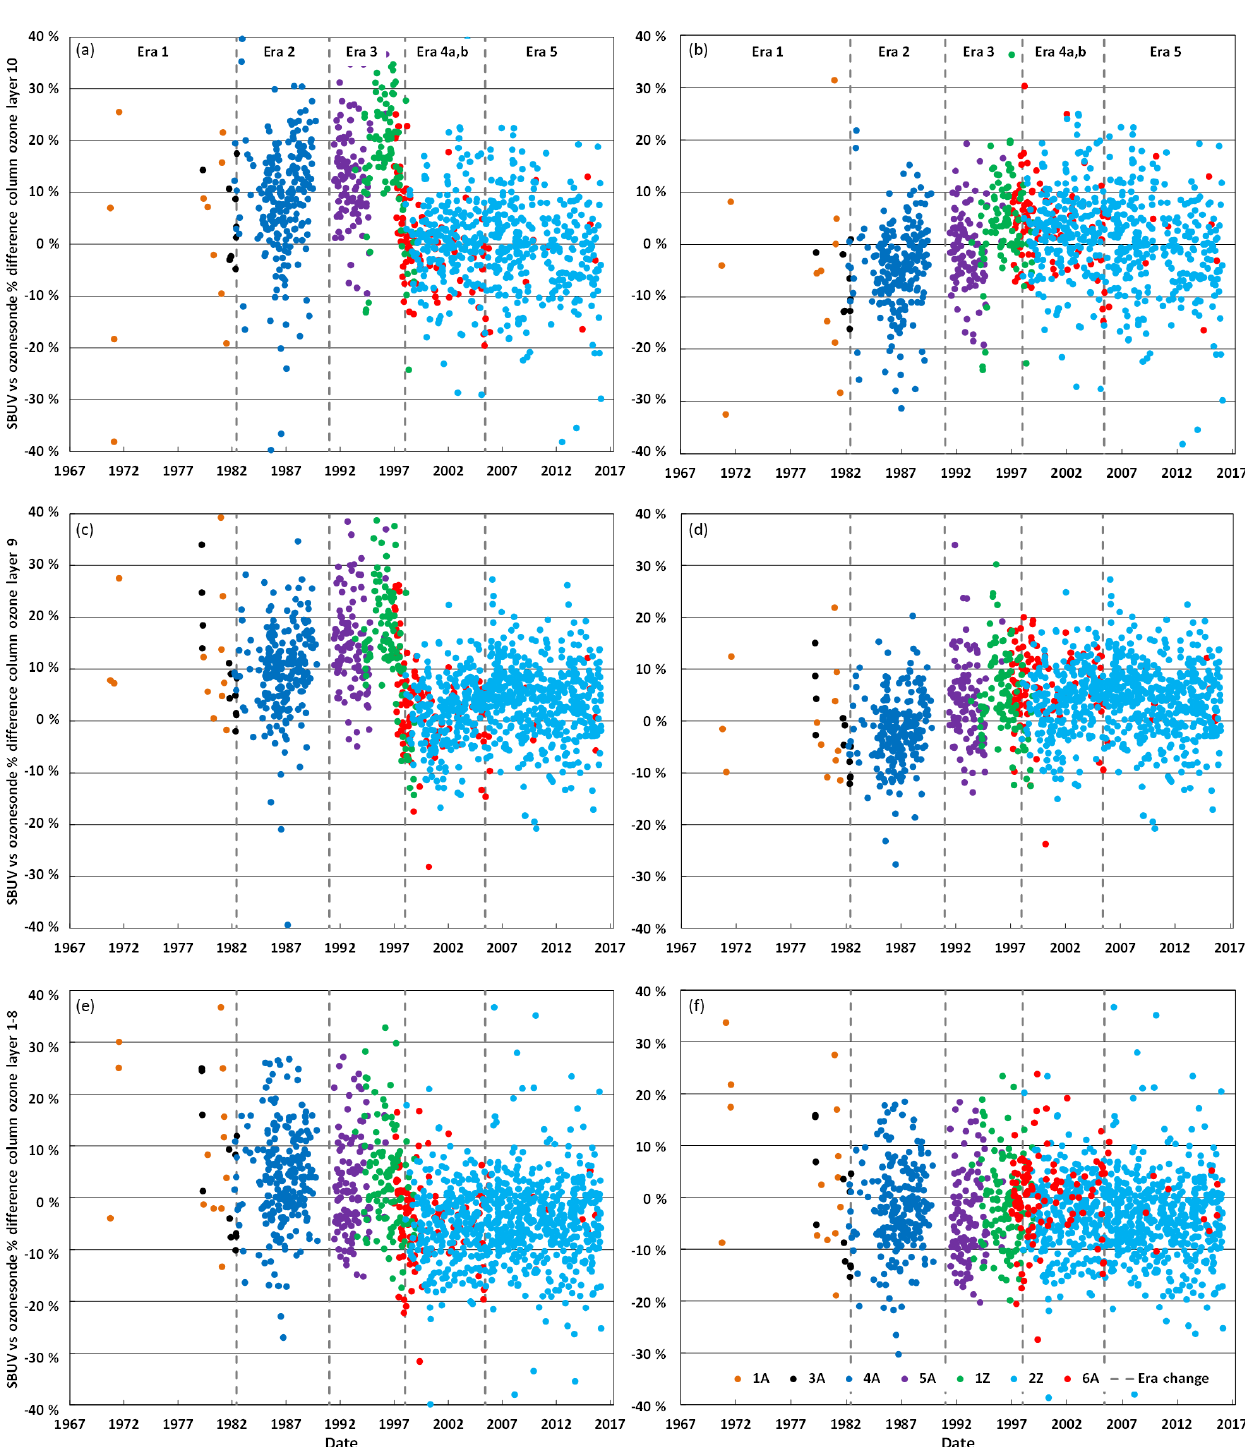
Figure 13. Percent difference in column ozone between the merged SBUV ozone data and the ozonesonde data at Boulder, CO. Panels (e) and (f) show Layers 1–8 (surface–25.45hPa), panels (c) and (d) show Layer 9 (25.45–16.06hPa), and panels (a) and (b) show Layer 10 (10.13– 16.06hPa). Panels (a) , (c) , and (e) show before and panels (b) , (d) and (f) show after applying the ozone sensor